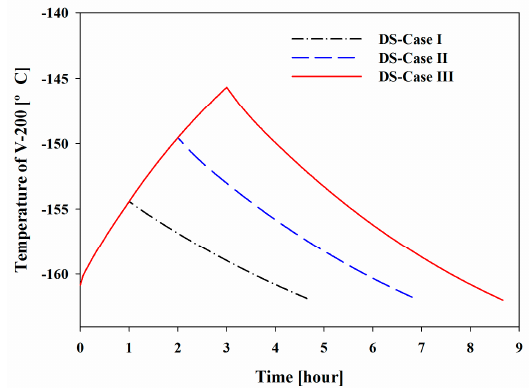
Figure 10. Temperature changes in V-200 with BOG inflow rate.